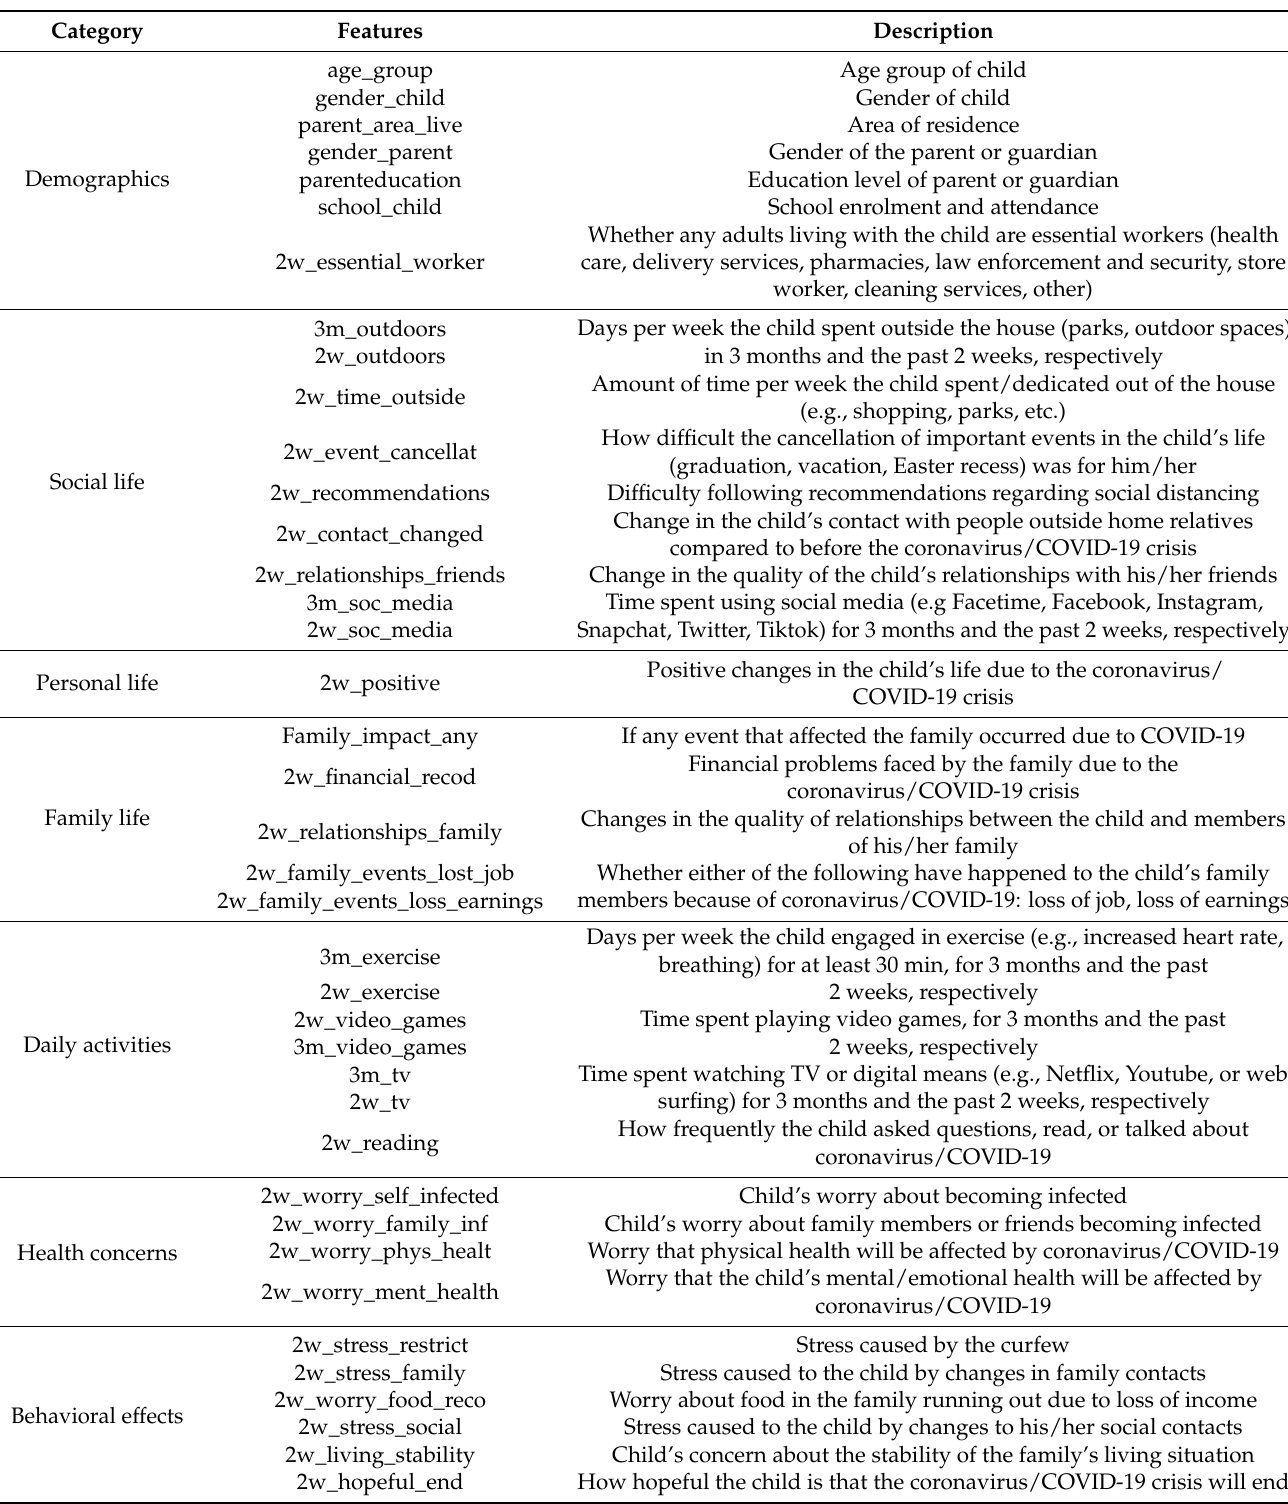
Table 4. Dataset